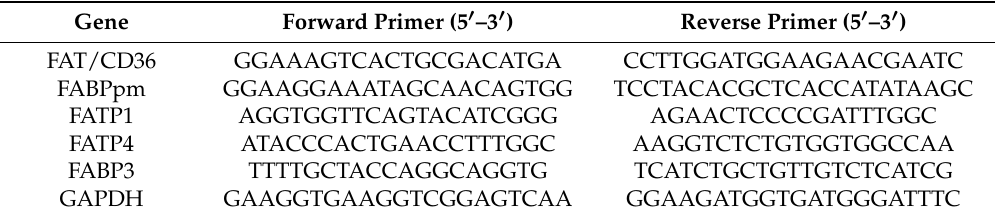
Table 1. List of primers used for quantitative